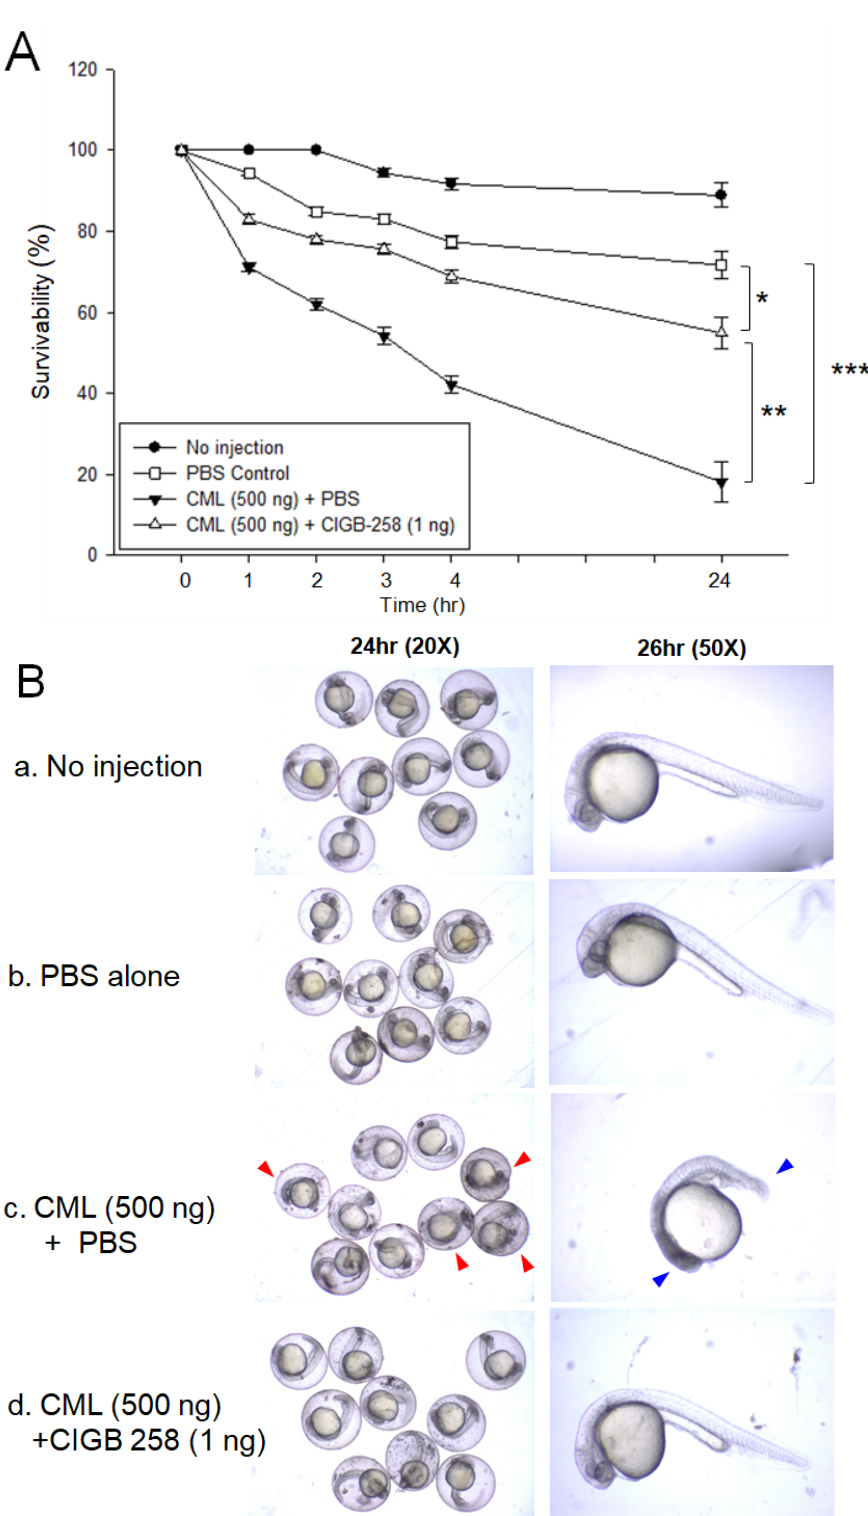
Figure 4. Toxicity of carboxymethyllysine (CML, final 500 ng) in zebrafish embryos in the presence or absence of CIGB-258 (final 1 ng). ( A ) Survivability of the zebrafish embryos during 24 h post-injection. *, p < 0.05; **, p < 0.01; ***, p < 0.001. ( B ) Stereoimage of the zebrafish embryos at 24 h post-injection. Red arrowheads indicate defected development and death of embryo in CML alone group (photo c). Blue arrowhead indicates the slowest developmental speed in eye pigmentation and tail elongation in CML alone group at 26 h-post injection (photo c). No injection control and PBS-injected control showed a normal developmental speed without defected embryos, as shown in Figure 4B (photos a and b). On the other hand, the CML-injected embryos showed the slowest developmental speed with the highest number of defects, as indicated by the red arrowhead with an abnormal mor-